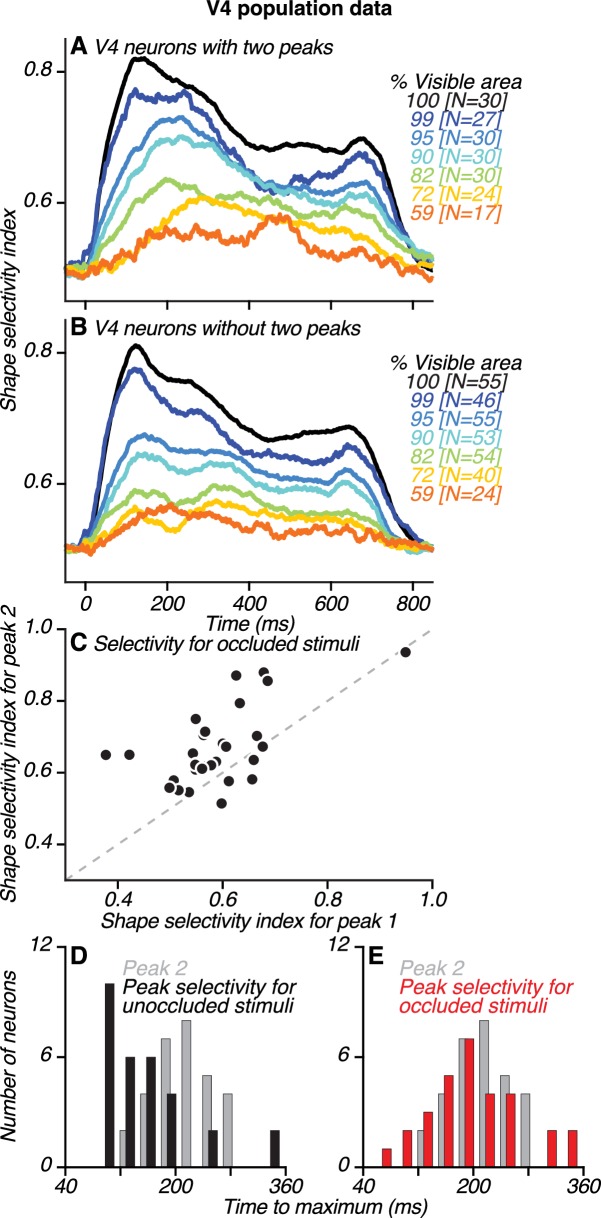
Dynamics of neuronal shape selectivity in V4.(A–B) Time course of average shape selectivity for unoccluded (black) and occluded (colors) stimuli for V4 neurons with two peaks (A) and V4 neurons without two peaks (B). For unoccluded stimuli (black), the time course and magnitude of shape selectivity were similar for the two neuronal groups. For stimuli at intermediate occlusion levels (72–95% visible area), shape selectivity was stronger and reached a maximal value later for neurons with two peaks (compare corresponding colors in A and B, also see Figure 8—figure supplement 1). (C) For most neurons with two peaks, shape selectivity at the time of the second peak (ordinate) was stronger than during the first peak (abscissa). Shape selectivity for occluded stimuli was significantly higher during the second peak than during the first peak (t Test, p<0.01). We computed shape selectivity using ROC analysis across all occlusion trials (i.e. % visible area <100) based on spike counts in a 30 ms window centered around the times of the first and second peaks, respectively (also see Figure 8—figure supplement 2). (D–E) For neurons with two peaks, the time of the second peak (gray) is compared to the time of maximal shape selectivity (black and red), separately for unoccluded (black, D) and occluded stimuli (red, E). Shape selectivity for unoccluded stimuli reached a maximal value significantly earlier than the second peak (t Test, p<0.01); this was not the case for occluded stimuli (t Test, p=0.98). Also see Figure 8—figure supplements 3–6.